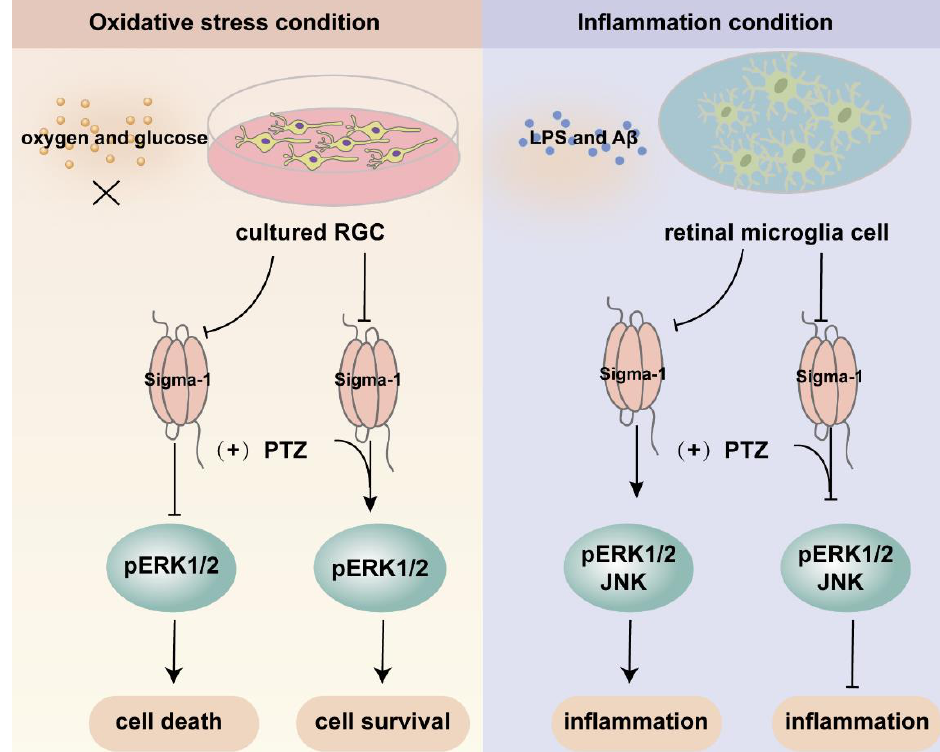
Figure 4. An overview of the mechanism of sigma-1 receptor modulates oxidative stress and inflam- matory response in retina through MAPK signaling pathway. Upon oxygen and glucose deprivation in cultured RGC, the expression of sigma-1 receptor and pERK1/2 was suppressed. The activation of sigma-1 receptor enhanced the expression of pERK1/2 and cell survival. While under inflammation condition, the inflammatory response was suppressed through downregulating the expression of pERK1/2 and JNK by sigma-1 receptor.